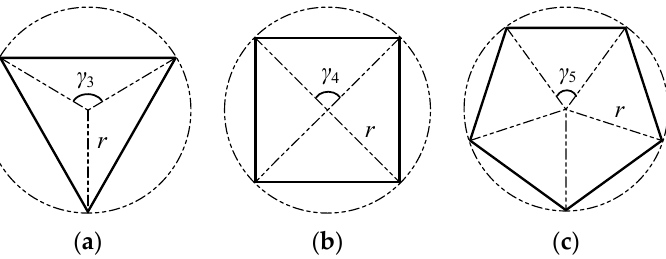
Figure 6. Schematic representation of the spindle head section with various shapes: ( a ) equilateral triangular section, ( b ) normal quadrilateral section, ( c ) regular pentagon section; (note: in the presented subfigures, γ 3 , γ 4 , and γ 5 are, respectively, the wrapping angles of the equilateral triangle section, the equilateral quadrilateral section, and the equilateral pentagon section, °; r is the circumcircle radius of the spindle head section).